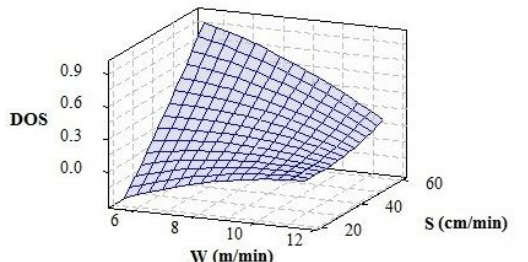
Figure 6. Response surface for interaction effect of welding speed ( S ) and wire feed rate ( W ) on degree of sensitization ( DOS ) ( N = 20 mm; V = 29.5